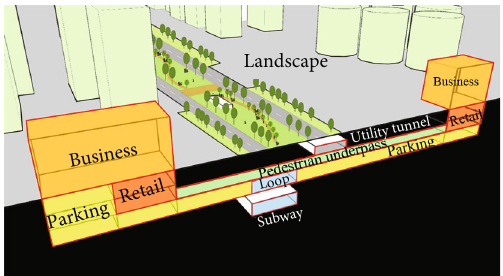
Figure 6: Stereo planning of underground space (source: self-created per the relevant information).